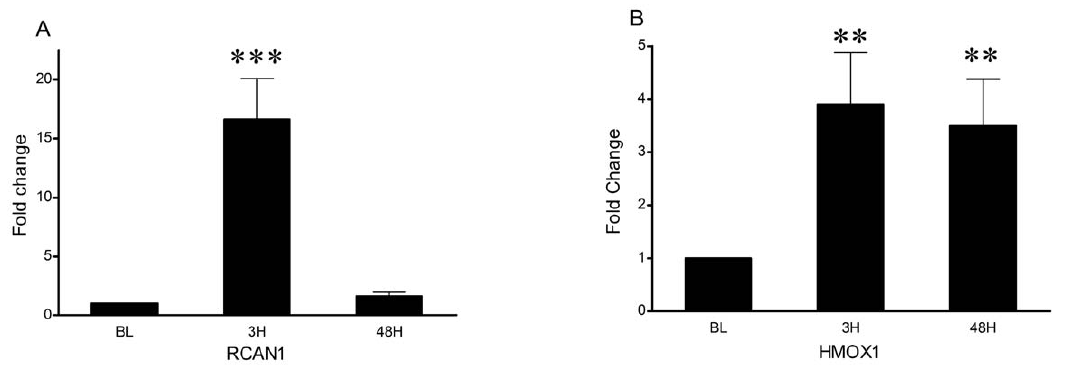
Figure 1. Expression fold changes in mRNA expression of genes in muscle from baseline after exercise protocol. Graph A – RCAN1 (N=18). Graph B – HMOX1 (N=18). 3H=3 hours post exercise, 48H=48 hours post exercise. Values are mean 6 SEM. **Significant difference vs. baseline when collapsed across supplementation (P , 0.01). ***Significant difference vs. baseline when collapsed across supplementation (P , 0.001).